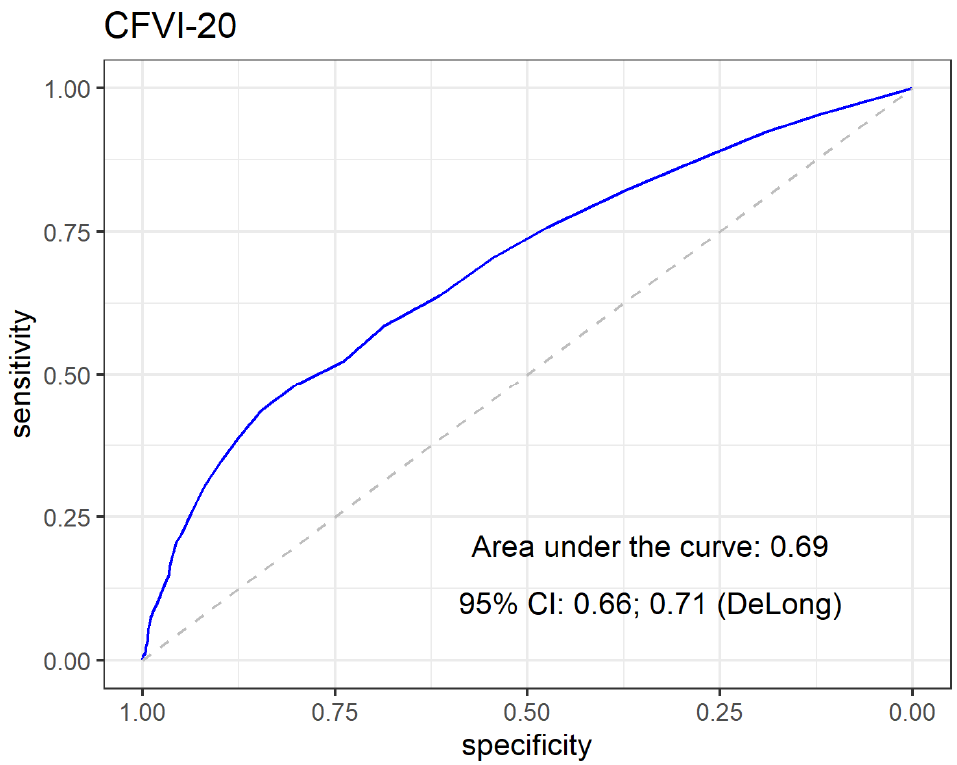
Figure 2. The receiving operating characteristics curve (ROC) and the area under the curve (AUC) to identify falls in older adults using the Clinical-Functional Vulnerability Instrument.